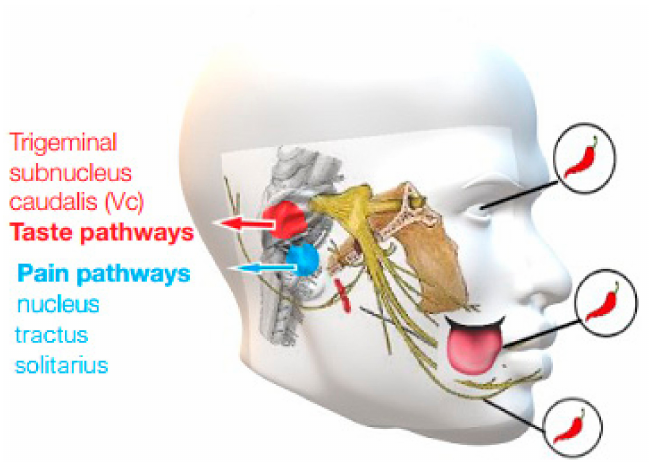
Figure 5. Sites of Capsaicin injection into ophthalmic, maxillary, and mandibular branches. Trigeminal neuralgia (TN) is characterized by recurrent paroxysmal attacks similar to electric shocks in the area of trigeminal nerve innervation [103], often involving both facial skin and intraoral mucosa. TN can be triggered by physiologically harmless stimuli, such as tooth brushing, mouth opening, phonation, or chewing, or following the intake of acidic or spicy solutions